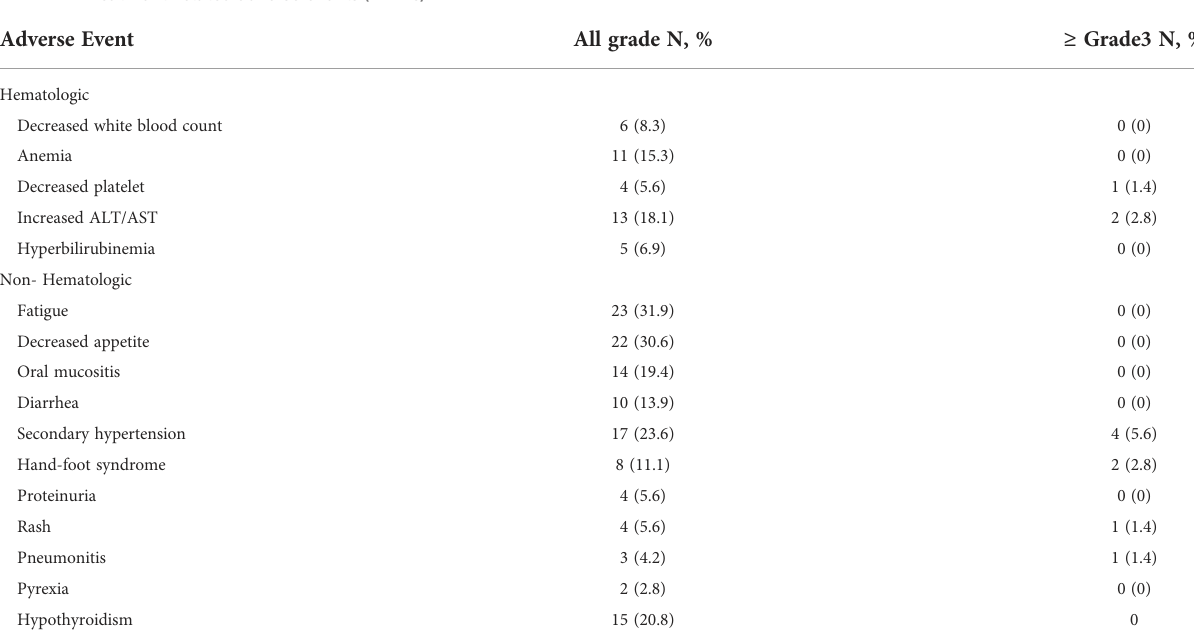
TABLE 4 Treatment-related adverse events